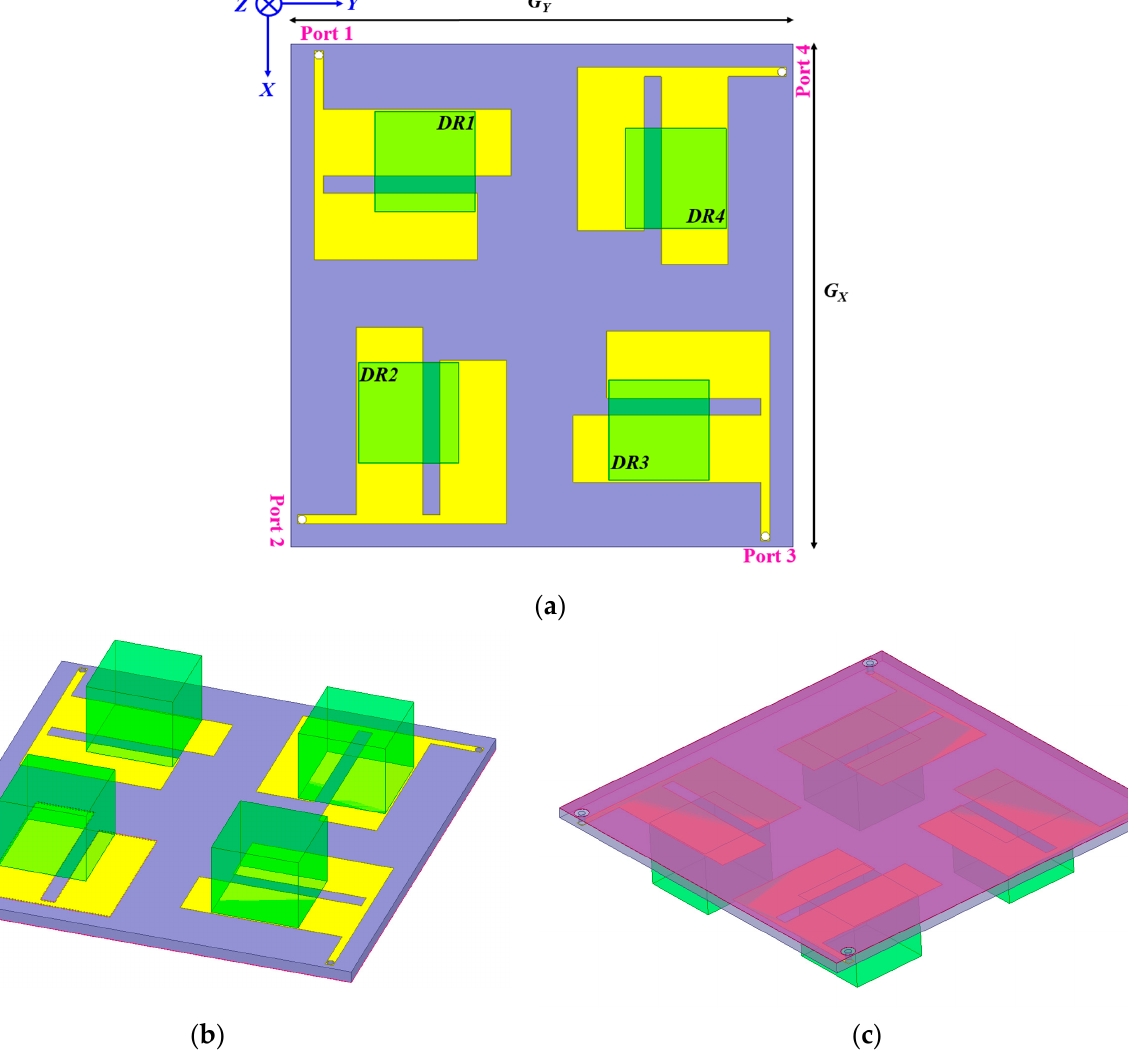
Figure 5. MIMO antenna view; ( a ) top; ( b ) perspective-top; and ( c ) perspective ground.